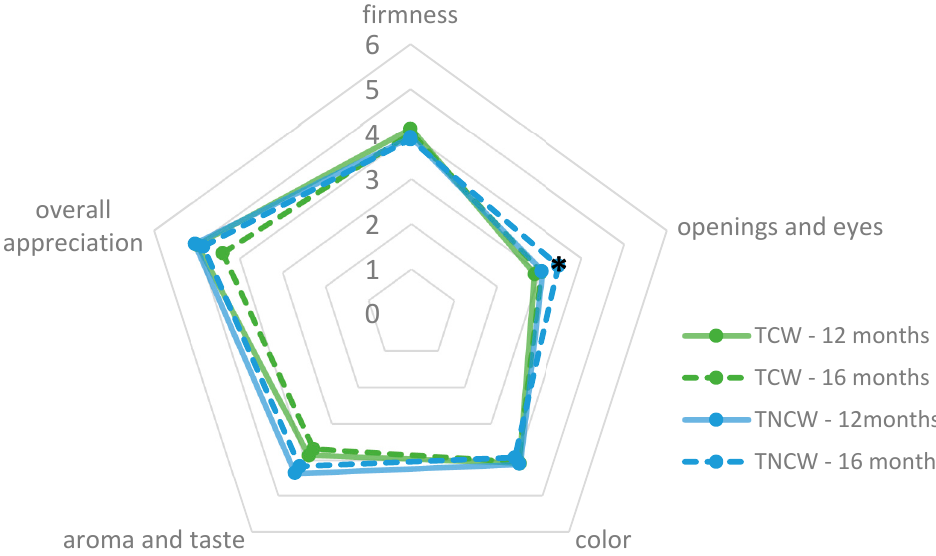
Figure 5. Quantitative descriptive analysis scores (1–7 ordinal scale) for sensory attributes evaluated by Nostrano Valtrompia cheese consumers. The mean score value (4) represents the optimal value for firmness, aroma and taste, color, opening and eyes; for overall appreciation the maximum value of 7 represents the ideal best score. Asterisks ( * ) represent a significant difference ( p < 0.05) between treatments for the specific sensory attribute.